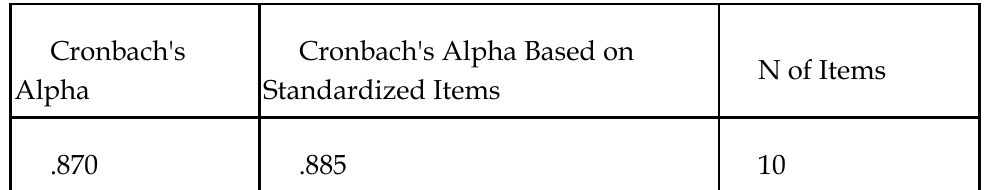
Table 2: Reliability Statistics